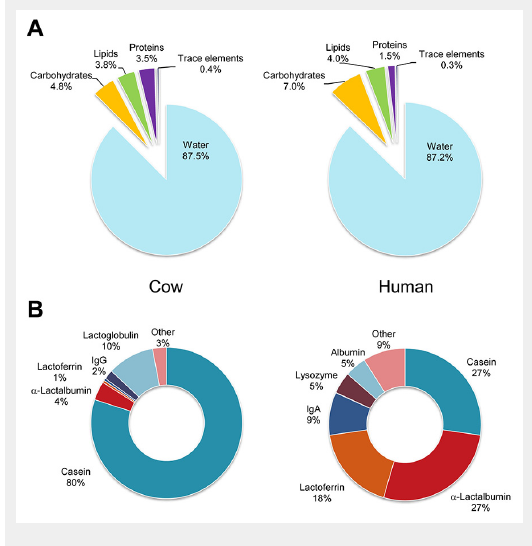
Composition of breast milk and cow’s milk. (A) General molecular classes given in percent of total mass. (B) Percentage of main types of milk